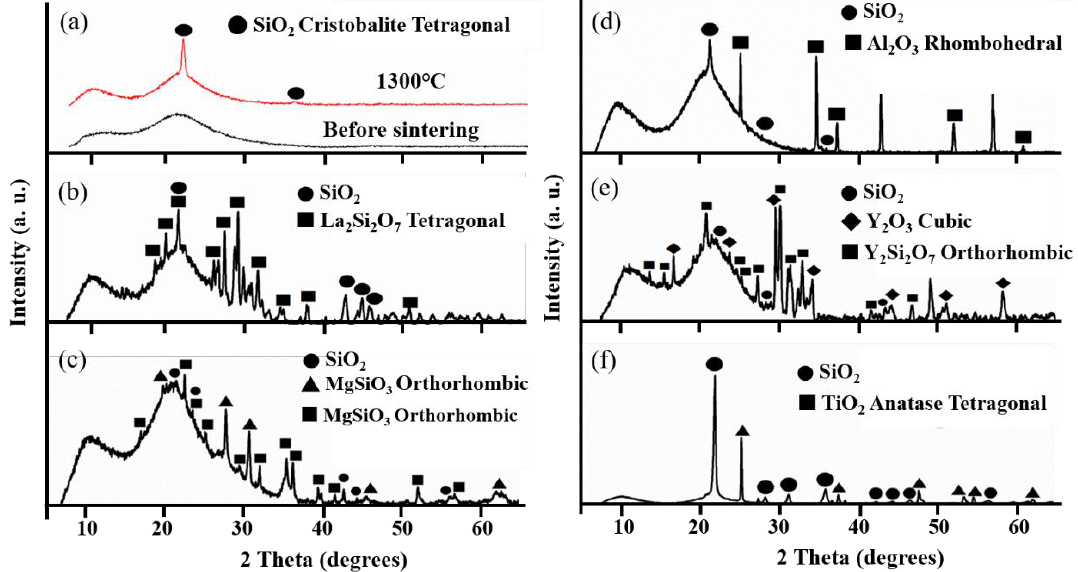
Figure 3. XRD spectra of ( a ) SiO 2 and ( b – f ) SiO 2 with 10 wt.% Al 2 O 3 , La 2 O 3 , Y 2 O 3 , MgO, and TiO 2 , respectively.